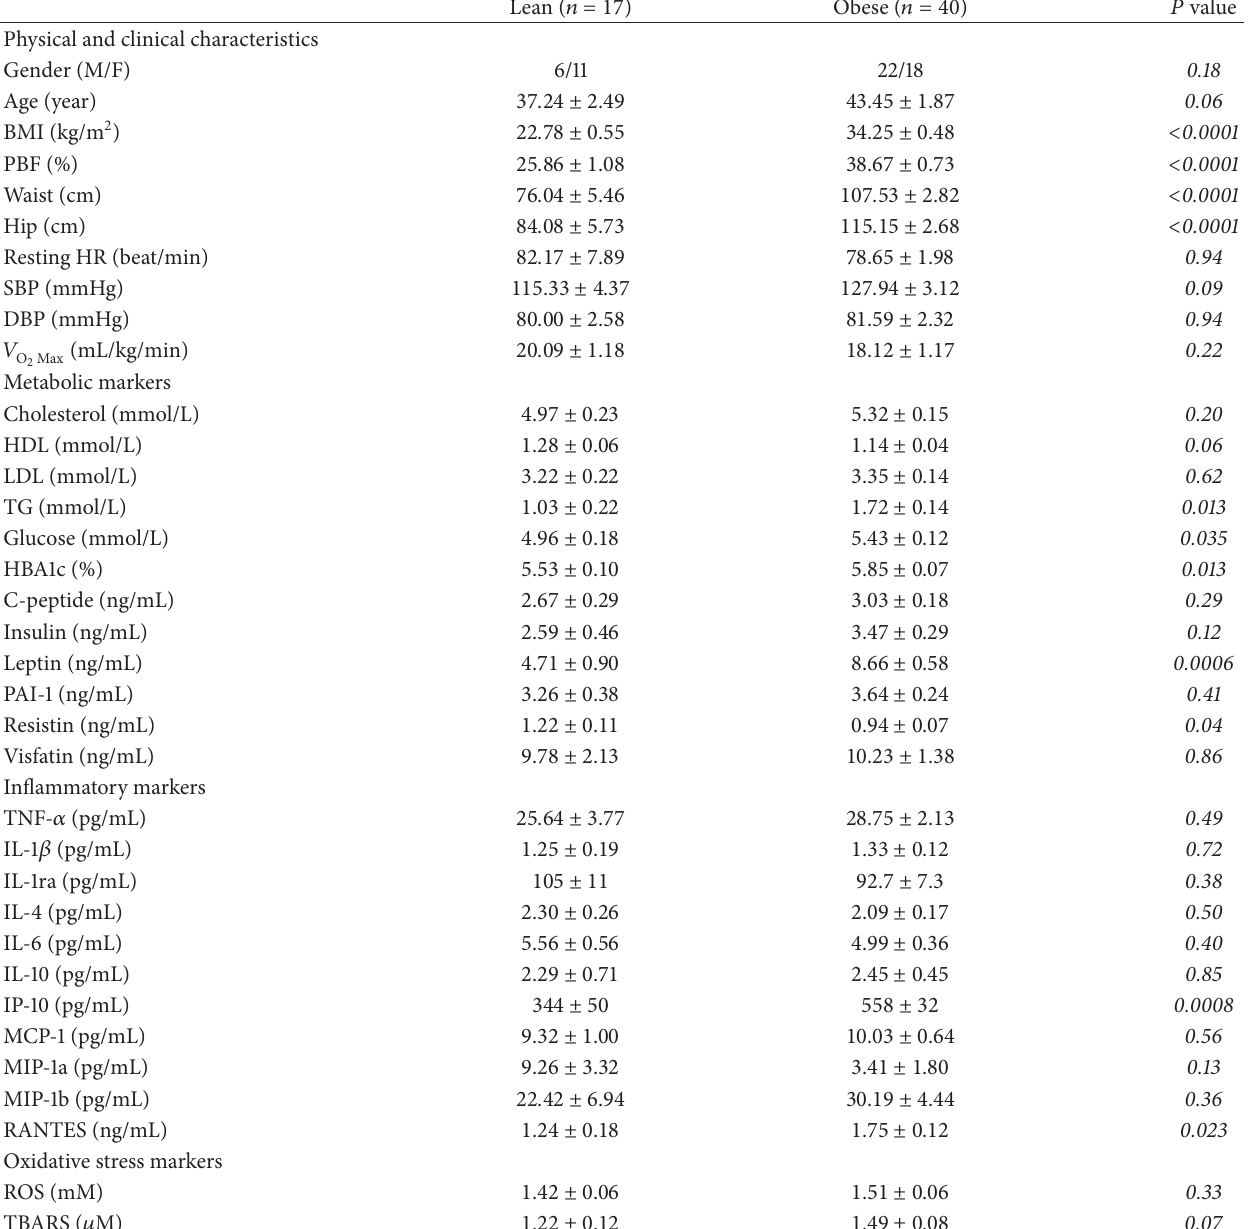
Table 1: Physical, clinical, and biochemical characteristics of the study population at